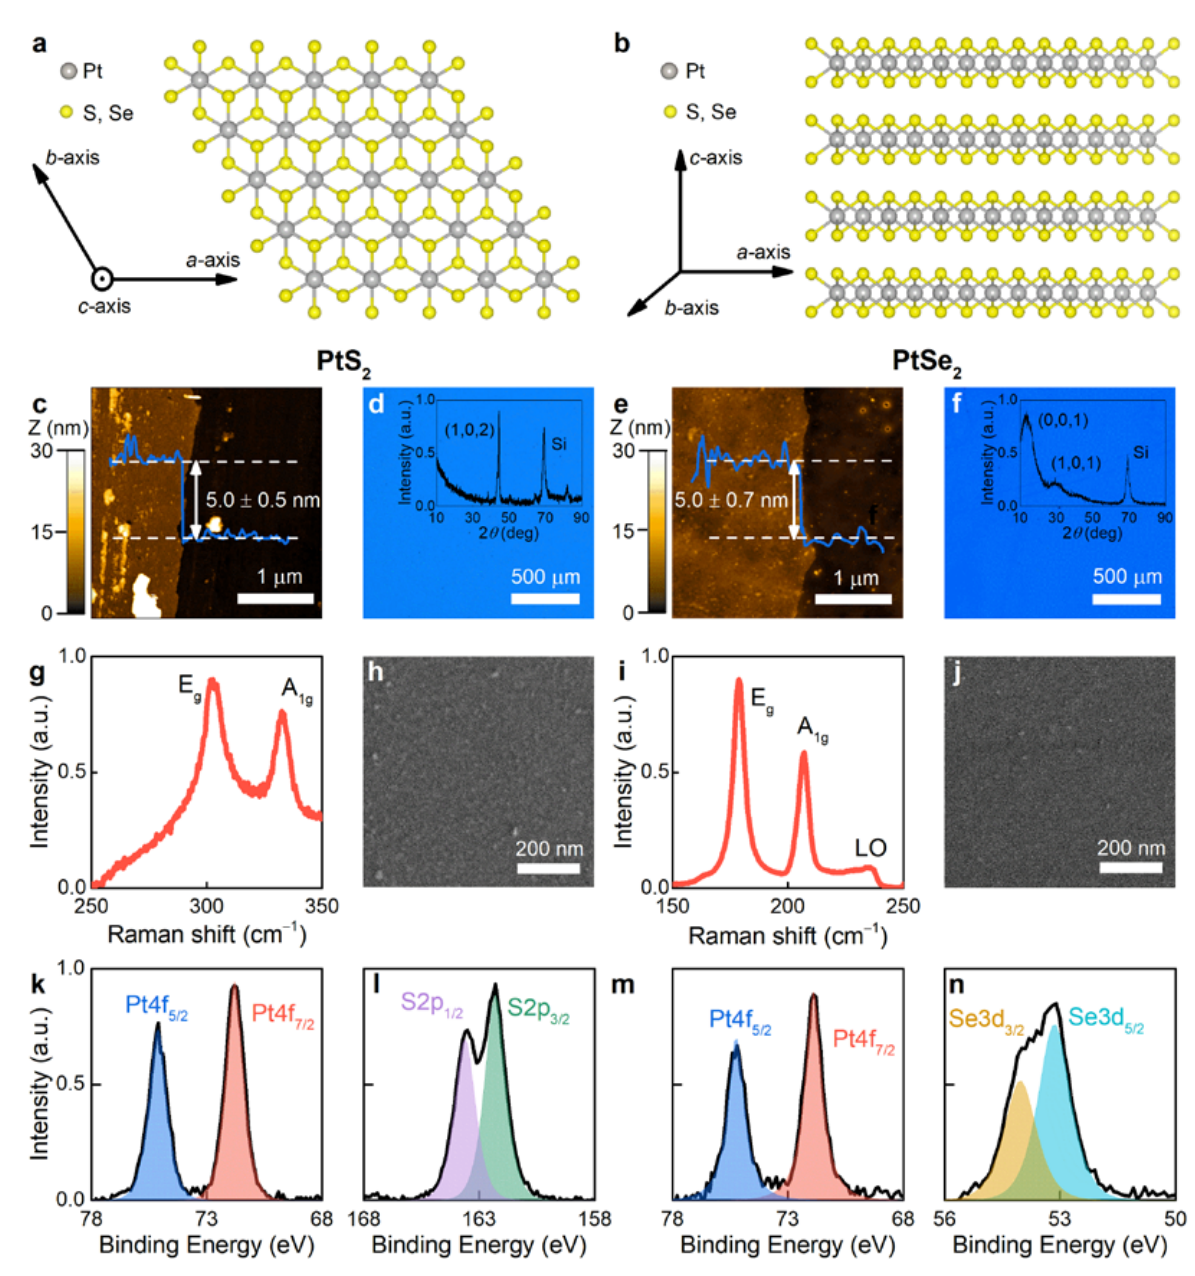
Figure 1. Characterization of PtS 2 and PtSe 2 films. Crystal structure of PtS 2 and PtSe 2 from different views along ( a ) (001) and ( b ) (210) directions. AFM topography mappings and cross-sectional profiles of the edge of ( c ) PtS 2 and ( e ) PtSe 2 . Optical images of ( d ) PtS 2 and ( f ) PtSe 2 on top of 300 nm SiO 2 /Si substrate. The insets show XRD diffraction patterns for PtS 2 and PtSe 2 , respectively. Raman spectra at excitation wavelength λ = 632.8 nm of ( g ) PtS 2 and ( i ) PtSe 2 show characteristic Raman modes E g and A 1g . Note that PtSe 2 also has an additional peak labelled LO (longitudinal optical) resulting from the overlap between infrared active modes E u and A 2u [27]. SEM images of ( h ) PtS 2 and ( j ) PtSe 2 . XPS spectra of ( k , l ) PtS 2 and ( m , n ) PtSe 2 .